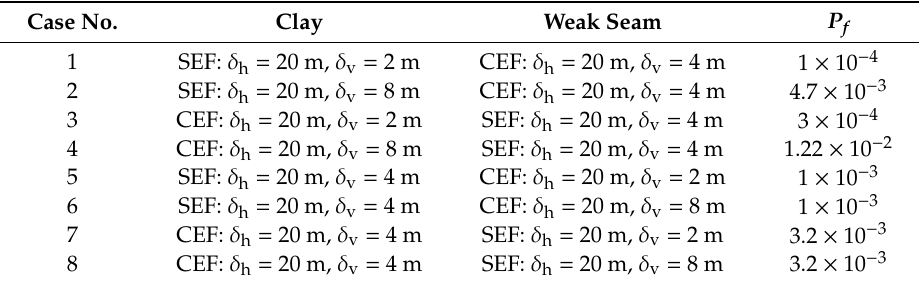
Table 6. Reliability results for di ff erent situations for example